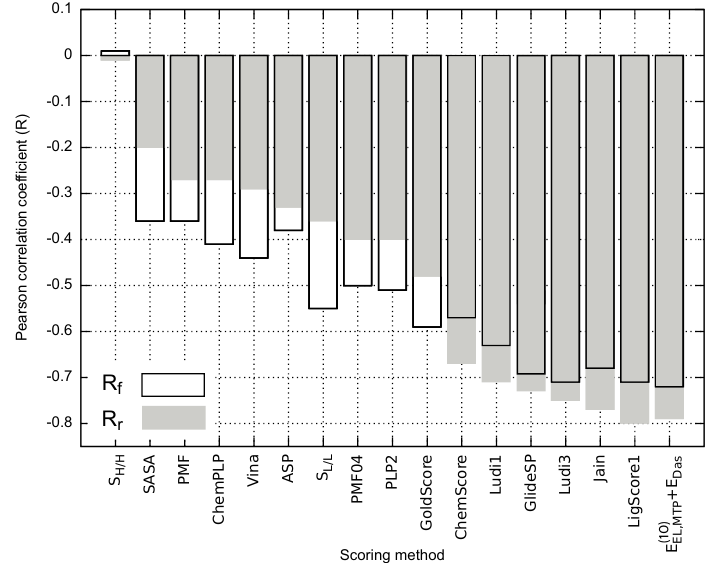
( 10 ) + E Das EL , MTP